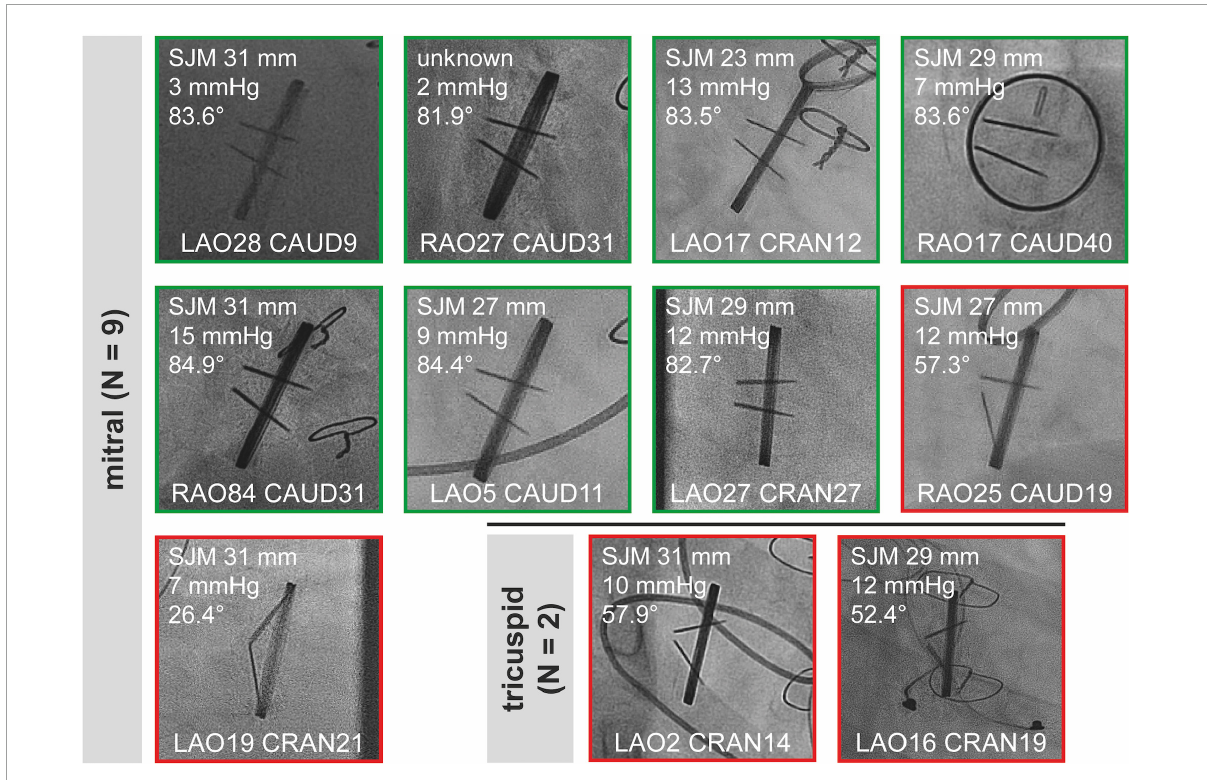
FIGURE3 Sufficient cinefluoroscopy studies of MHVs in mitral and tricuspid position. MHVs had either normal leaflet opening and closing (green) or leaflet dysfunction (red). MHVs are shown during maximum opening. Individual images show the opening angle (for details refer to Figure 1 ), mean gradient from transthoracic echocardiography, and projection angles in CF. For comparison, the mean opening angles of SJM, ATS, and Carbomedics MHVs are 83.4, 69.5, and 77.1 ◦ , respectively (12). Some images are already shown in Figure 1 . CAUD, caudal; CRAN, cranial; LAO, left anterior oblique; MHV, mechanical heart valve; RAO, right anterior oblique; SJM, St. Jude